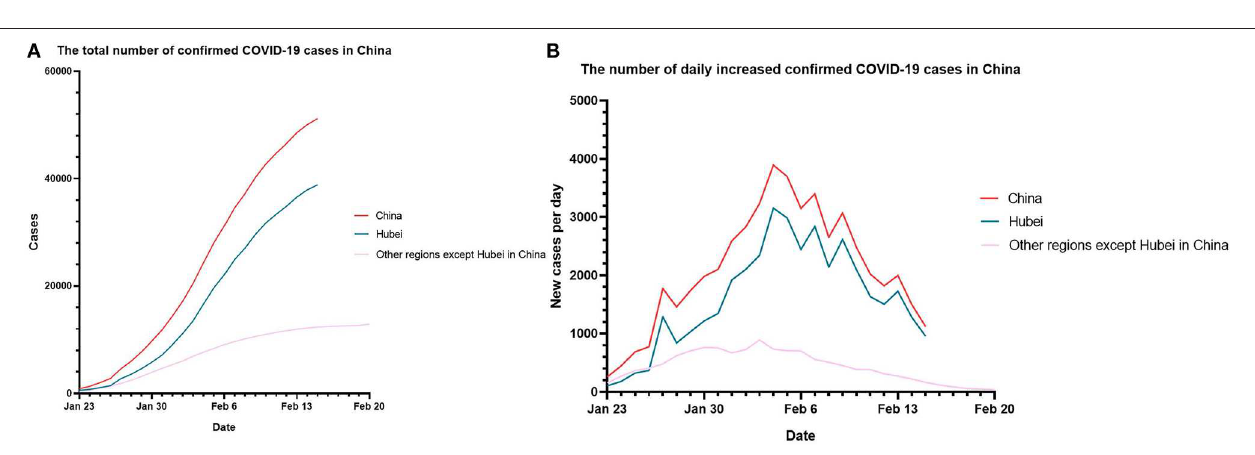
FIGURE 2 | The data of the number of confirmed cases in China between January 23, 2020 at 24 p.m. and February 20, 2020 at 24 p.m. (Beijing time) (A) . The total number of confirmed COVID-19 cases in China (B) . The number of daily increased confirmed COVID-19 cases in China. From February 16, 2020, in Hubei Province of China, the number of confirmed cases and clinical diagnosed cases were calculated together and reported as one number. Thus, the total number of cases for Hubei and China were presented till February 15,